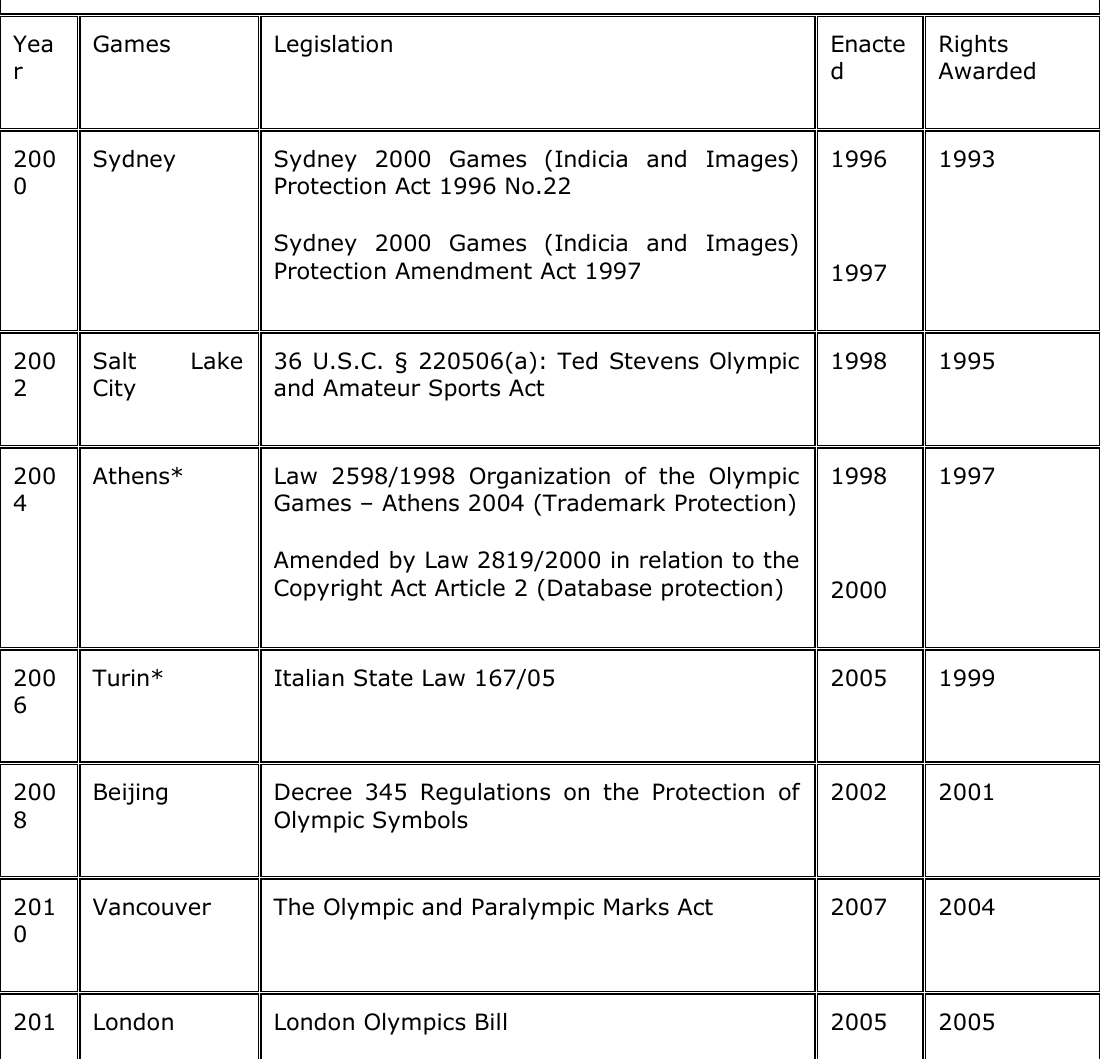
Table 2 documents the IPR protection related legal instruments specifically created for recent Summer and Winter Olympiads, from the millennium Games in Sydney to those in Rio de Janeiro, the recently appointed host city of the 2016 Summer Games. Table 2 – A Summary of Recent Legislation Enacted to Protect the Olympic Brand, Symbols, Indicia, and other